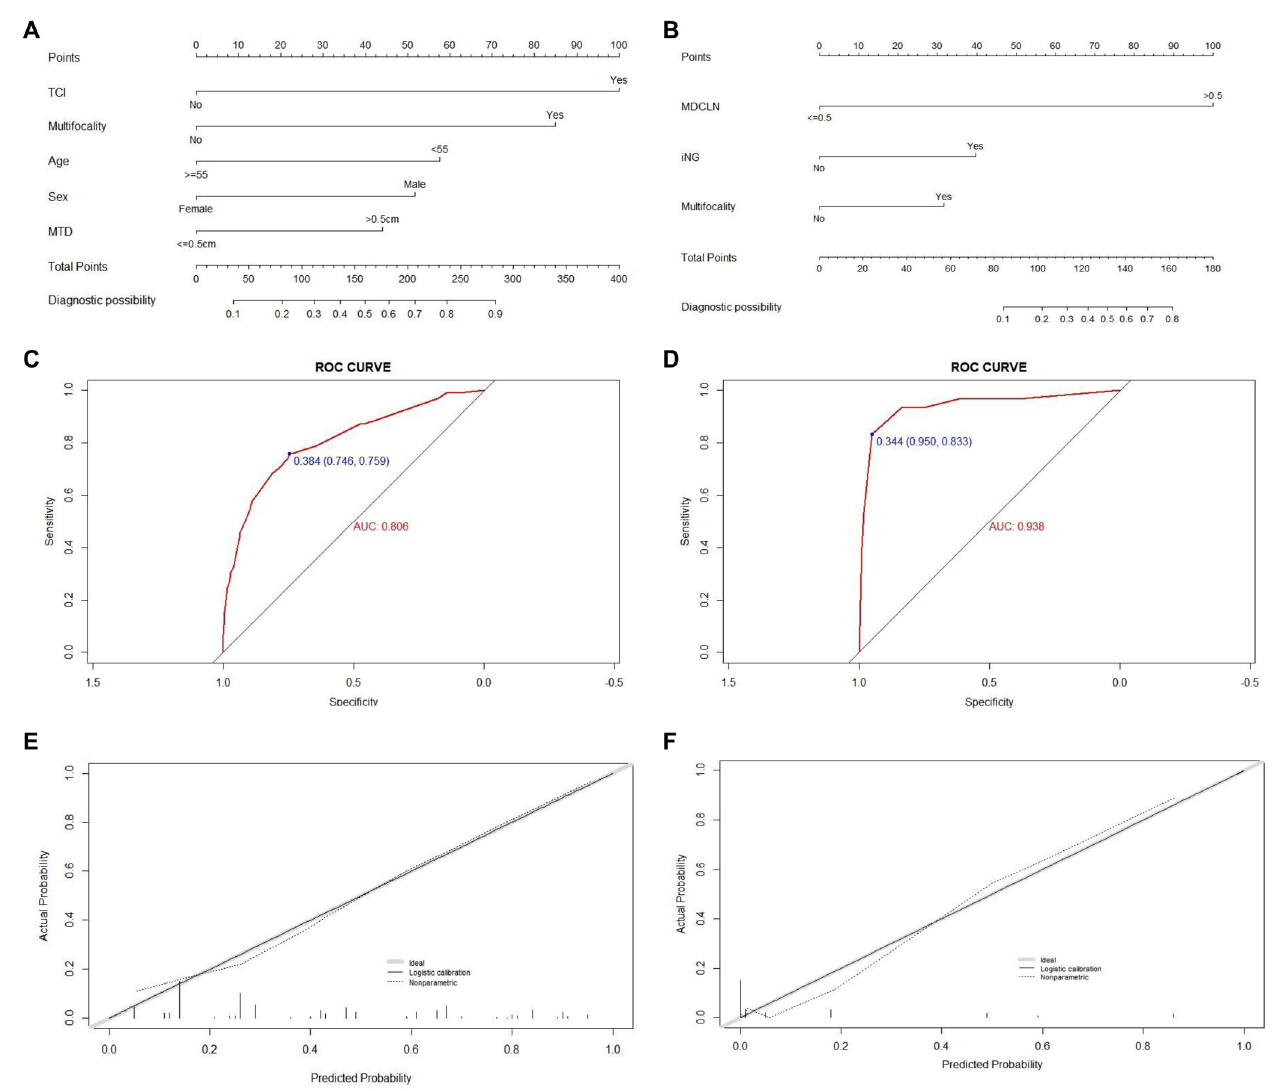
Figure 1. Construction, assessment, and validation of the predictive model of CLNM and LLNM. ( A , B ) The nomograms for predicting CLNM and LLNM risk in PTMC patients within the Uni group, respectively; ( C , D ) the ROC curve and AUC of the nomograms for predicting CLNM and LLNM risk in PTMC patients within the Uni group, respectively; ( E , F ) the calibration curves of the nomogram for predicting CLNM and LLNM risk in PTMC patients within the Uni group, respectively. Actual probability is plotted on the y-axis, and nomogram predicted probability on the x-axis. PTMC, papillary thyroid microcarcinoma; CLNM, central lymph node metastasis; LLNM, lateral lymph node metastases; TCI, thyroid capsular invasion; MTD, maximum tumor diameter; MDCLN, the maximum diameter of positive central lymph node; iNG, ipsilateral nodular goiter; ROC, receiver operating characteristics.